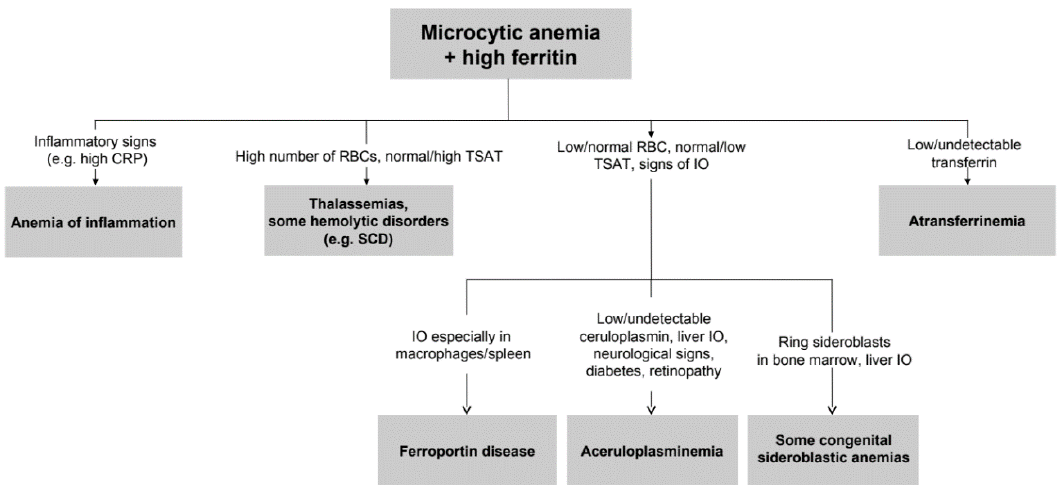
Figure 4. Simplified approach to microcytic anemia + high ferritin. From relatively simple laboratory tests also rare diseases can be suspected. Further investigations should include genetic testing, MRI for estimation of liver iron content, and eventually liver or bone marrow histopathology. IO: iron overload. SCD: sickle cell